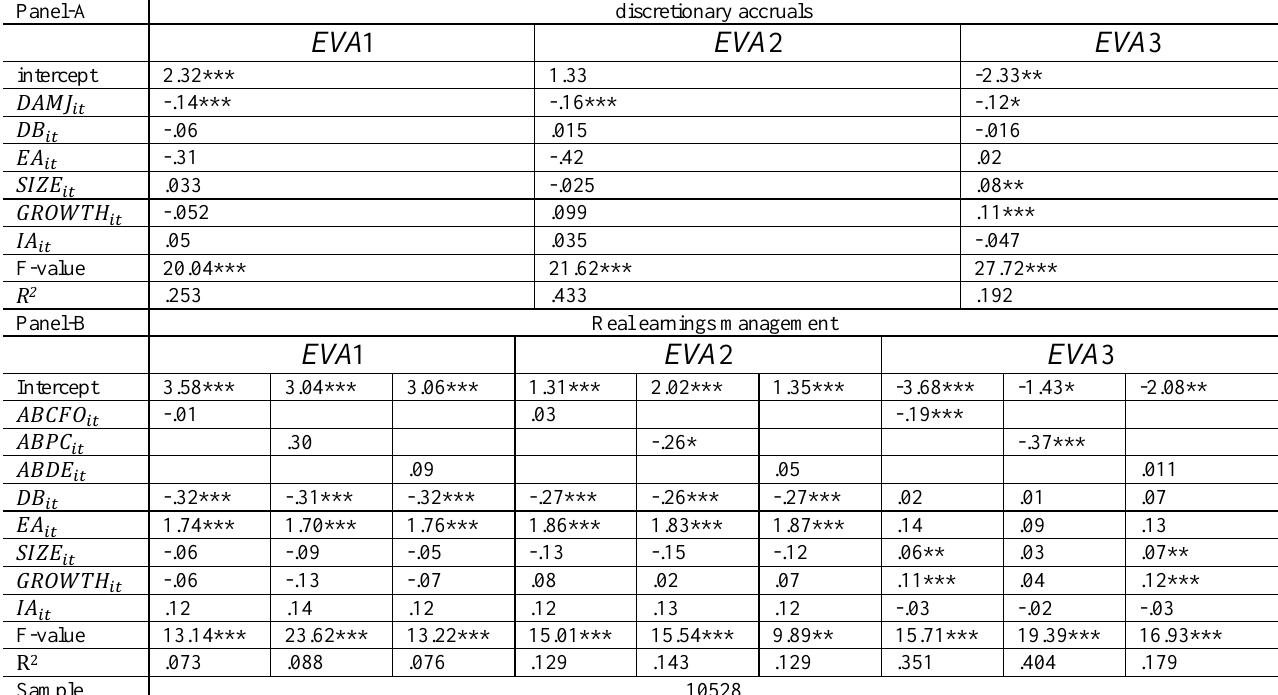
Table 4: Regressions of earnings management with economic value added (EVA) for European Union (EU) nations